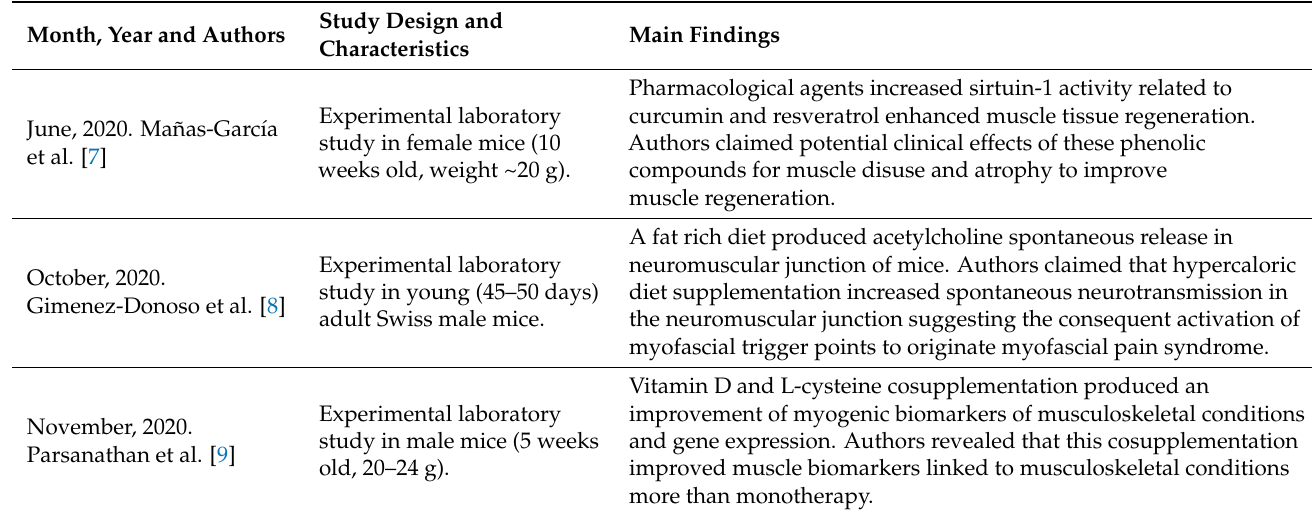
Table 2. Characteristics of the original research reports included in the Special Issue about nutrients and biomarkers in musculoskeletal